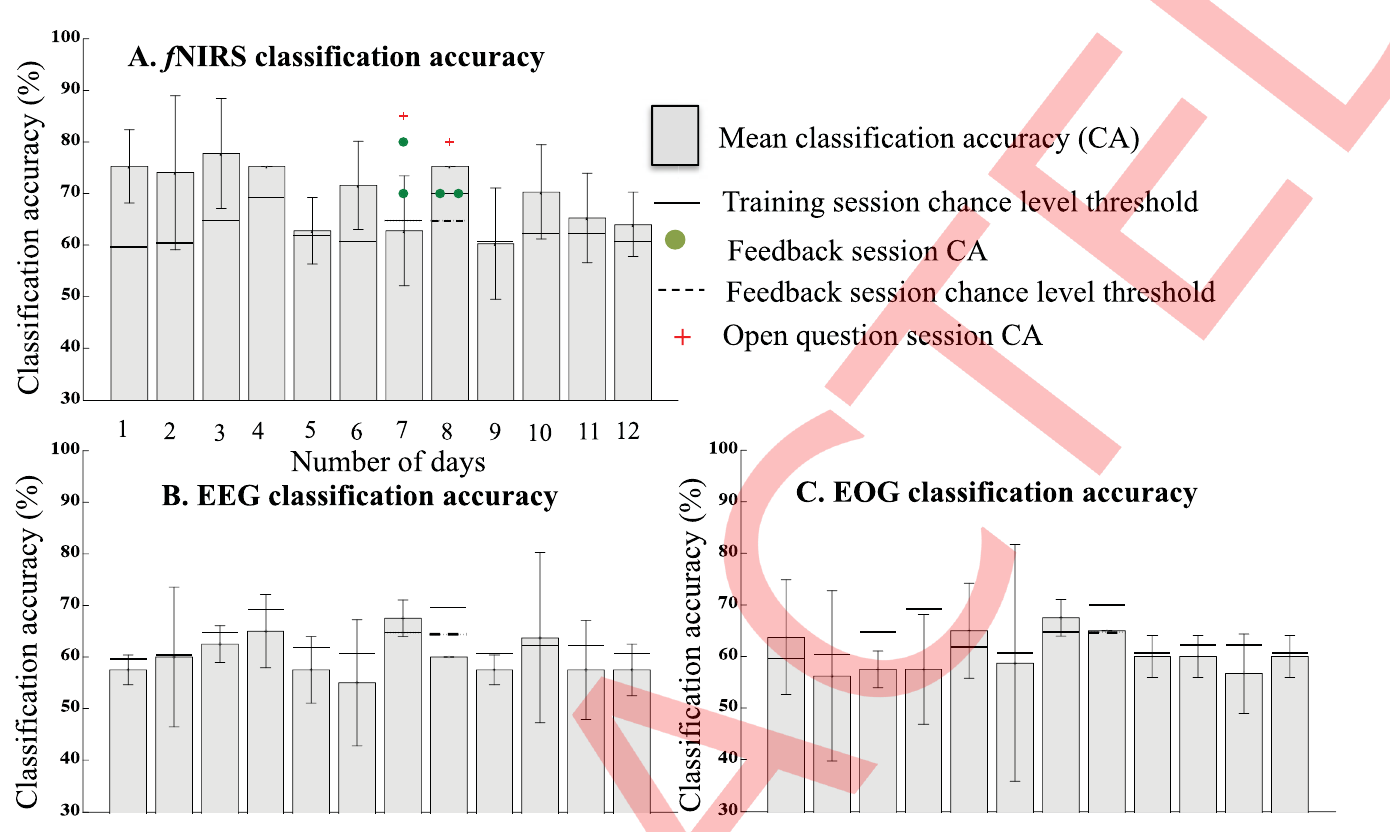
Fig 4. Classification accuracyof Patient B. The description of this figure is the same as describedin Fig 2. Fig 4 data is locatedat https://doi.org/10.5281/